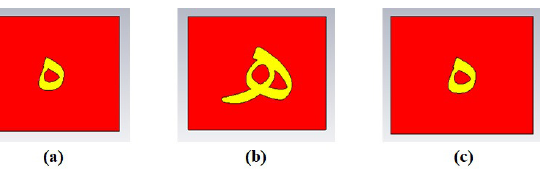
Figure 13. Designed letter (cid:232) tag with various fonts with the same size of 28: ( a ) Arial; ( b ) Calibri; ( c ) Times New Roman (TNR).